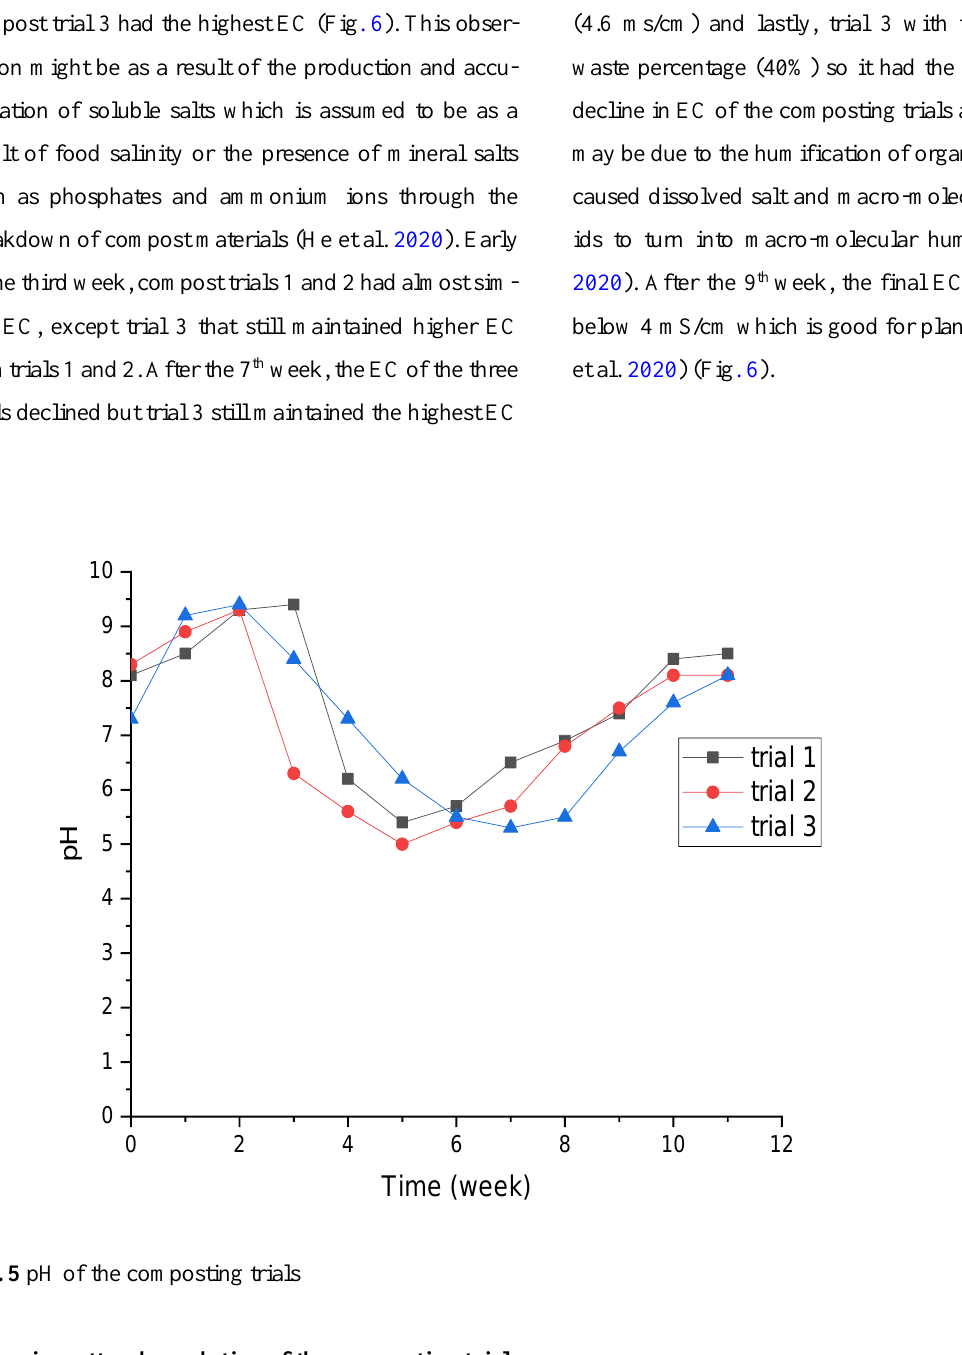
content in all the three composting trials showed a